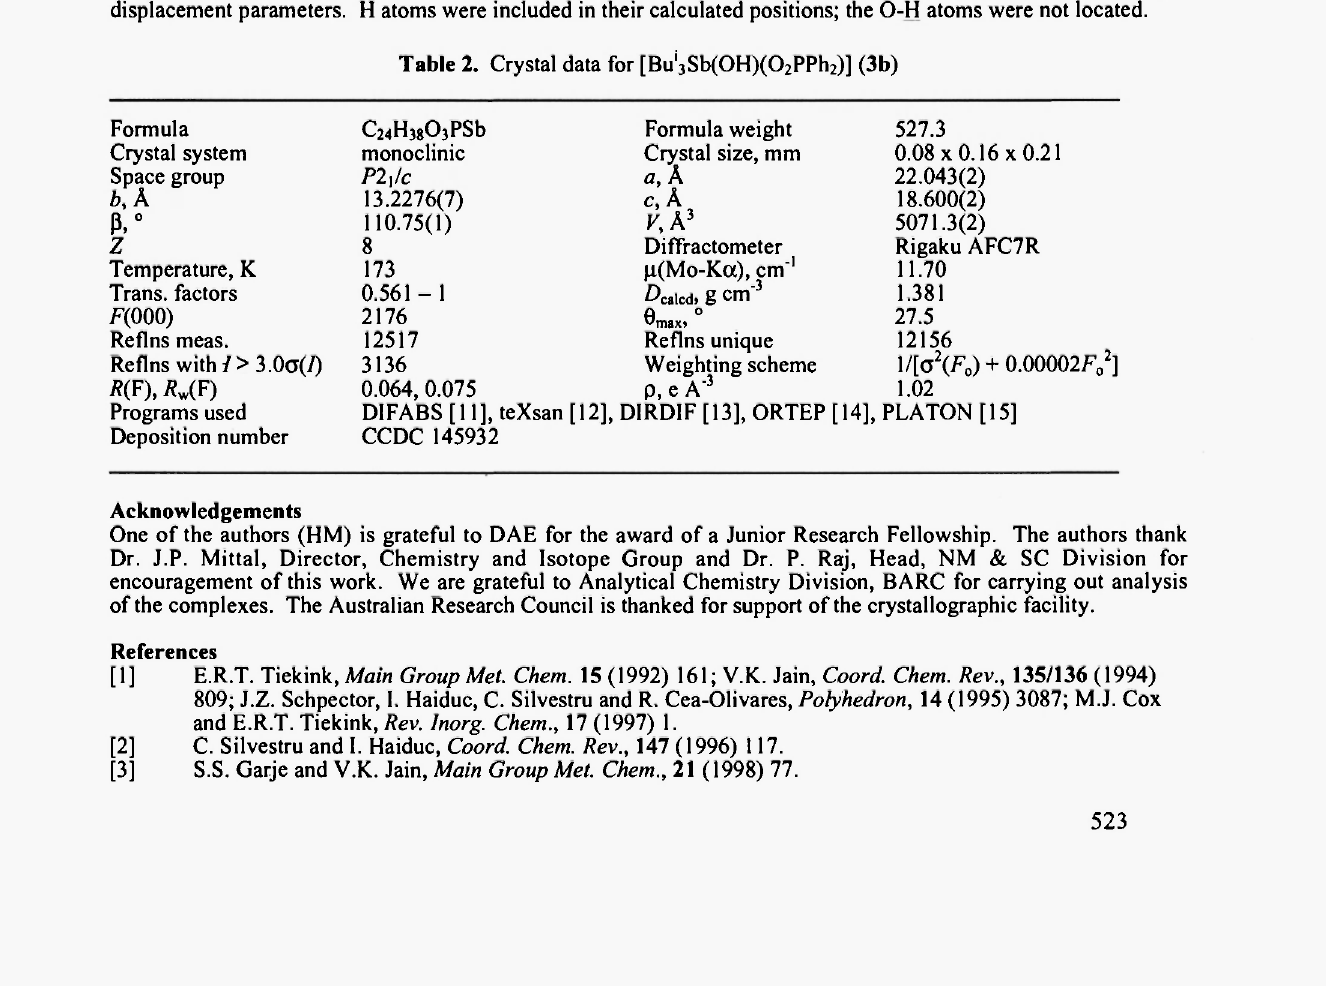
Table 2. Crystal data for [Bu'jStyOHXOjPPhz)]